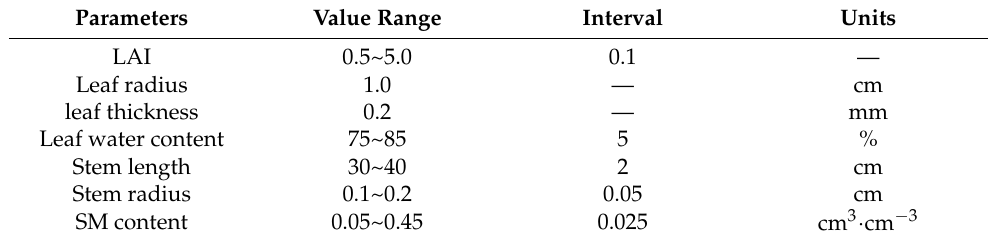
Table 2. The main input parameters of MIMICS model.